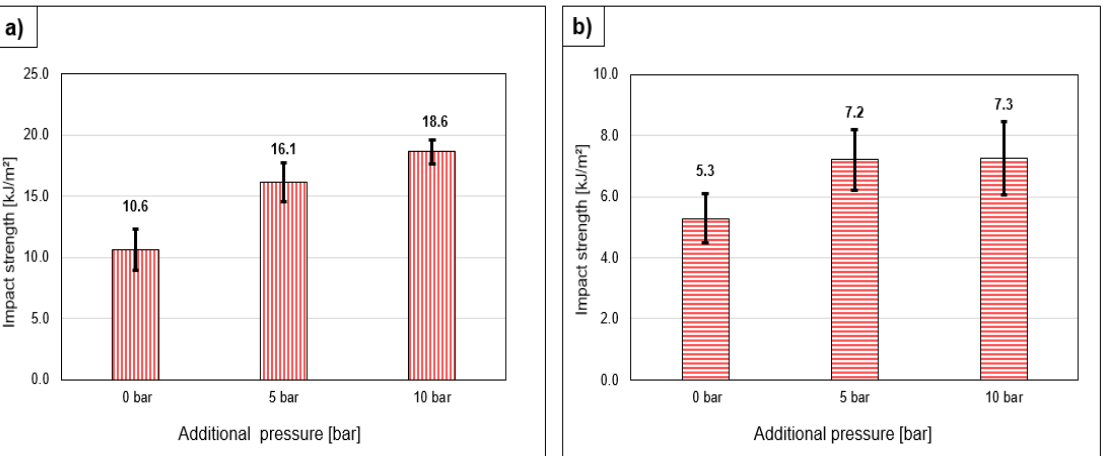
Figure 8. Impact strength comparison of samples printed under different pressure conditions ( a ) longitudinal and ( b ) transverse to the printing direction.